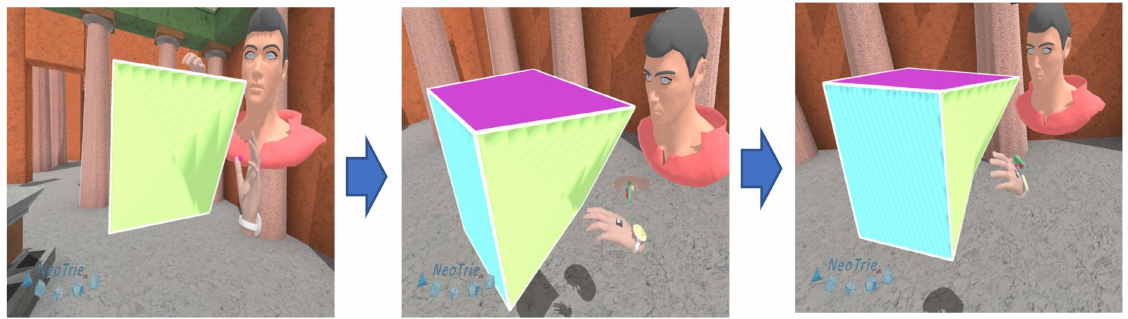
Figure 9. Geometric solid with non-planar faces.